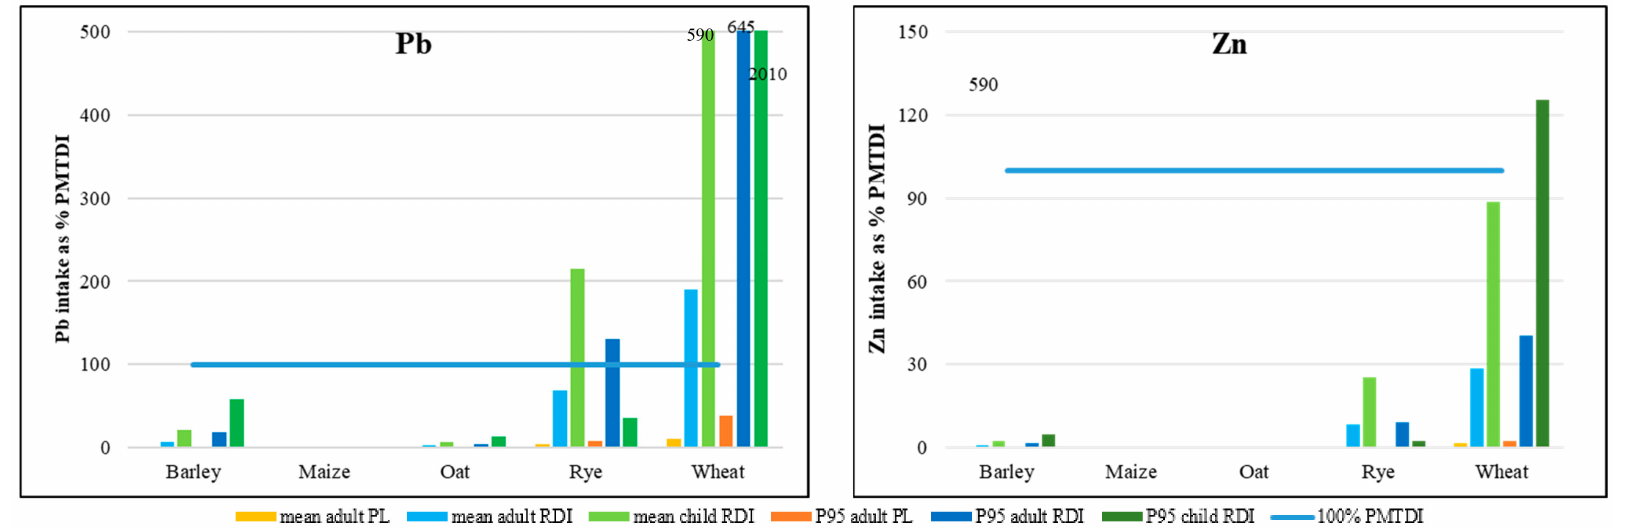
Figure 3. Daily intake rates of PHEs, with consumed cereals as a % of provisional maximum tolerable daily intake (%PMTDI); mean adult PL—daily intake rate for adults, statistical data for Poland [45], mean PHE concentration; mean adult RDI—recommended daily intake rate for adults [4], mean PHE concentration; mean child RDI—recommended daily intake rate for children [4], mean PHE concentration; P95 adult PL—intake rate for adults, statistical data for Poland [45], 95th percentile of PHE concentration; P95 adult RDI—recommended intake rate for adults [4], 95th percentile of PHE concentration; P95 child RDI—recommended intake rate for children [4], 95th percentile of PHE